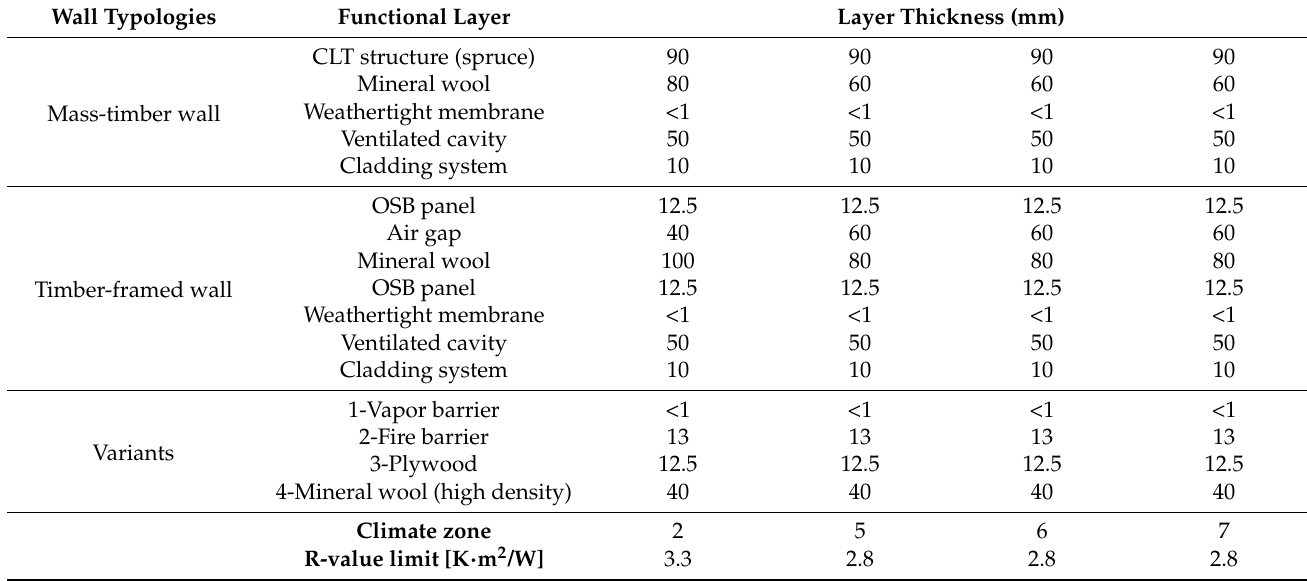
Table 2. Wall assemblies’ description. Layers are listed from indoor to outdoor, minimum R-value requirements for each climate zone [6] is noted.